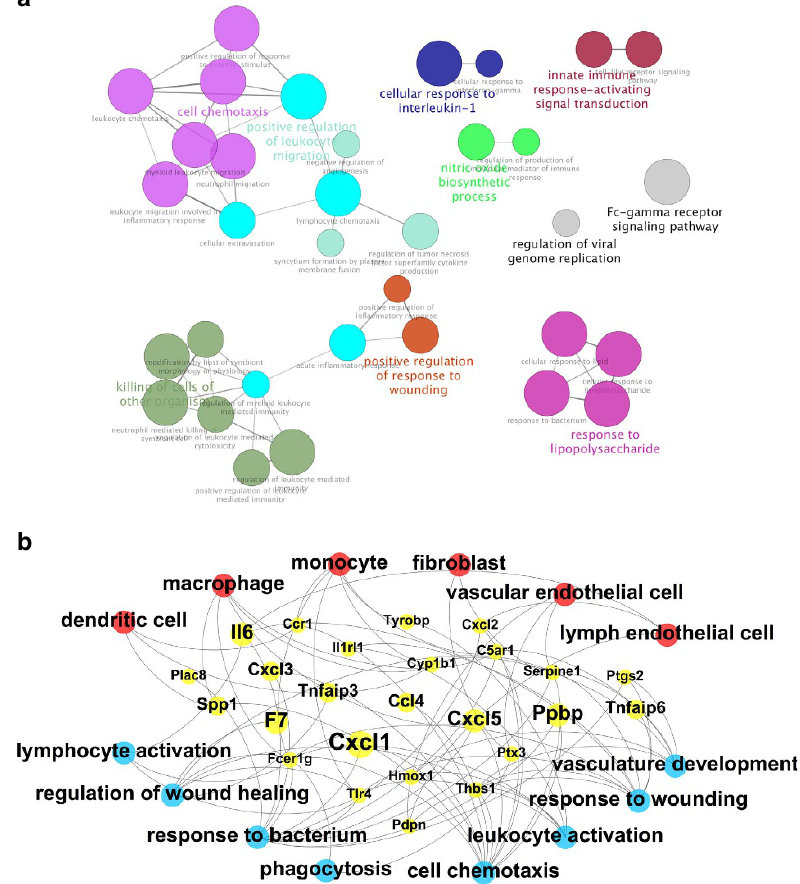
Figure 5 | Effect of vemurafenib on the biological pathways involved in wound healing. ( a ) Significantly activated biological process/pathways by day 6 of vemurafenib treatment based on the enriched gene ontology (GO) clusters visualized by ClueGO. ( b ) Integrated view highlighting specific wound-healing cell subsets (red; with signature enrichments), their upregulated genes (yellow) and enriched wound-healing-related processes (blue) in the transcriptome of mice wounds treated with vemurafenib by day 6. Gene node size represents induction at day 6, with the largest node representing a log2 (FC) of 4.54 and smallest node representing a log2 (FC) of